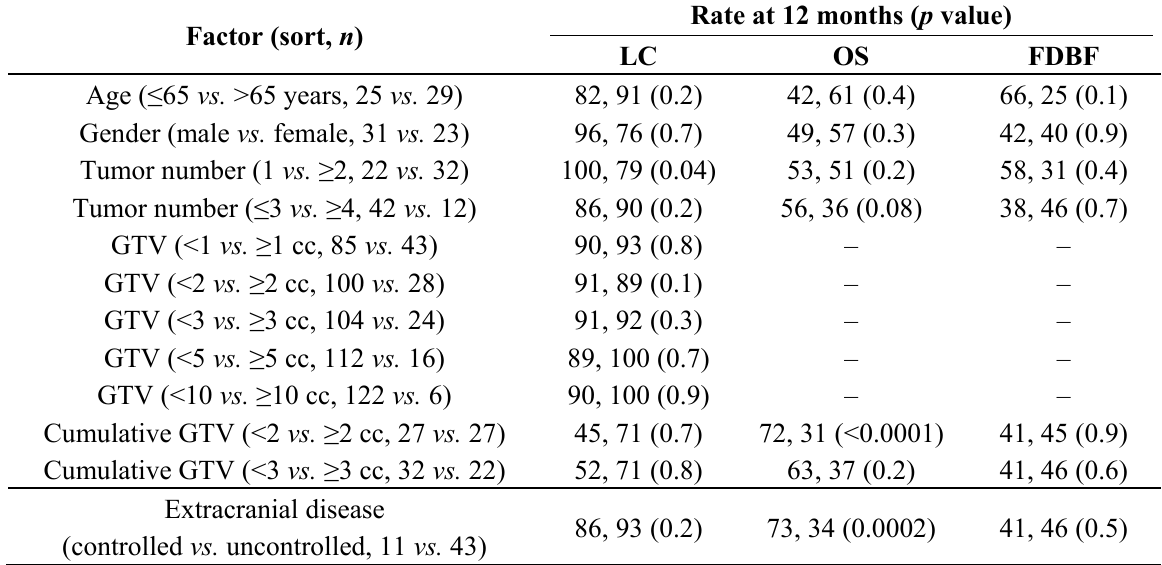
Figure 2. LC curves according to the gross tumor volume (GTV). There was no difference among the three groups ( p = 0.4).